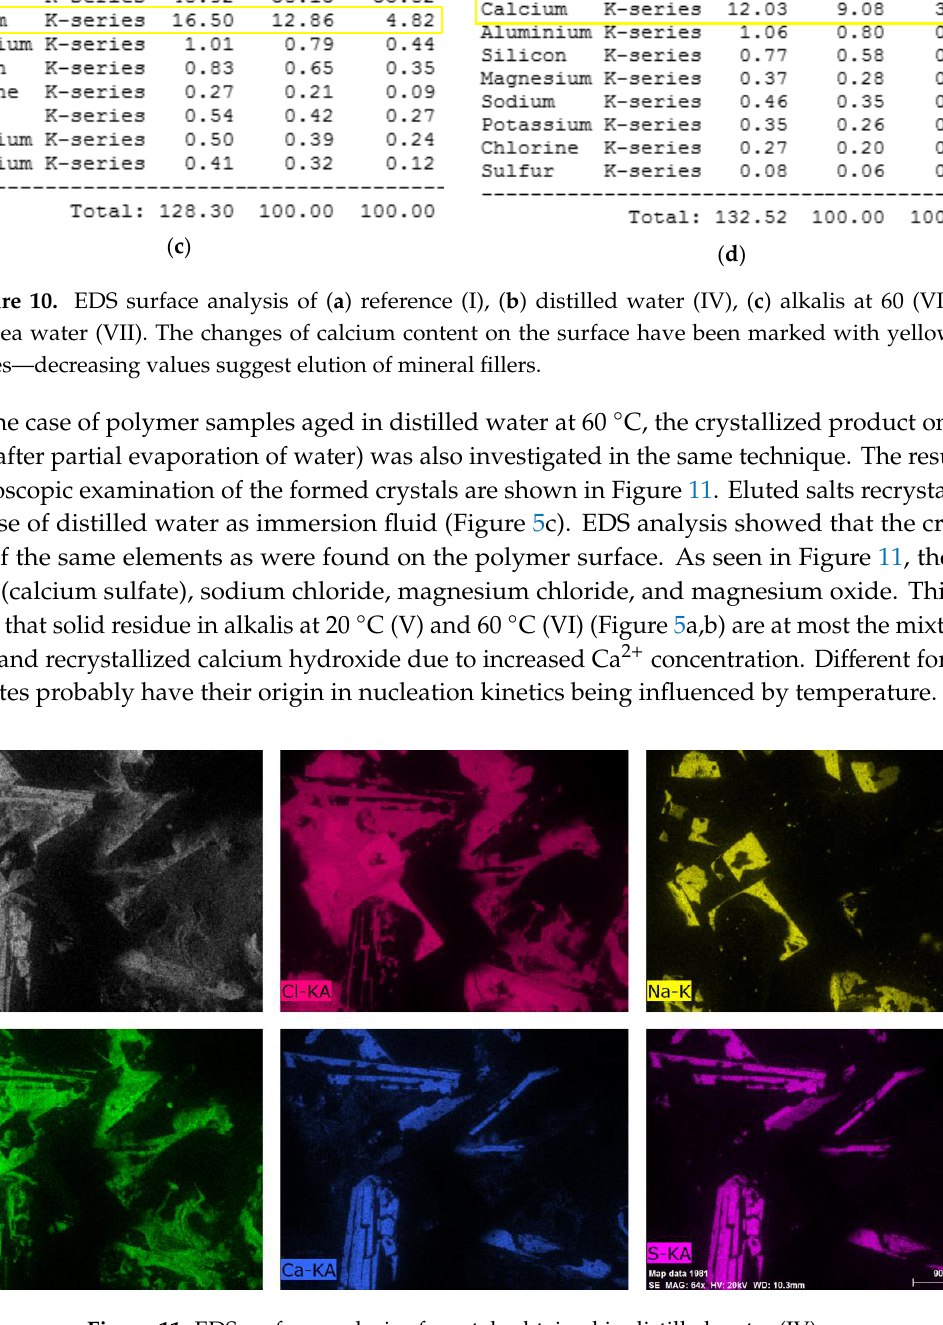
Figure 11. EDS surface analysis of crystals obtained in distilled water (IV) .